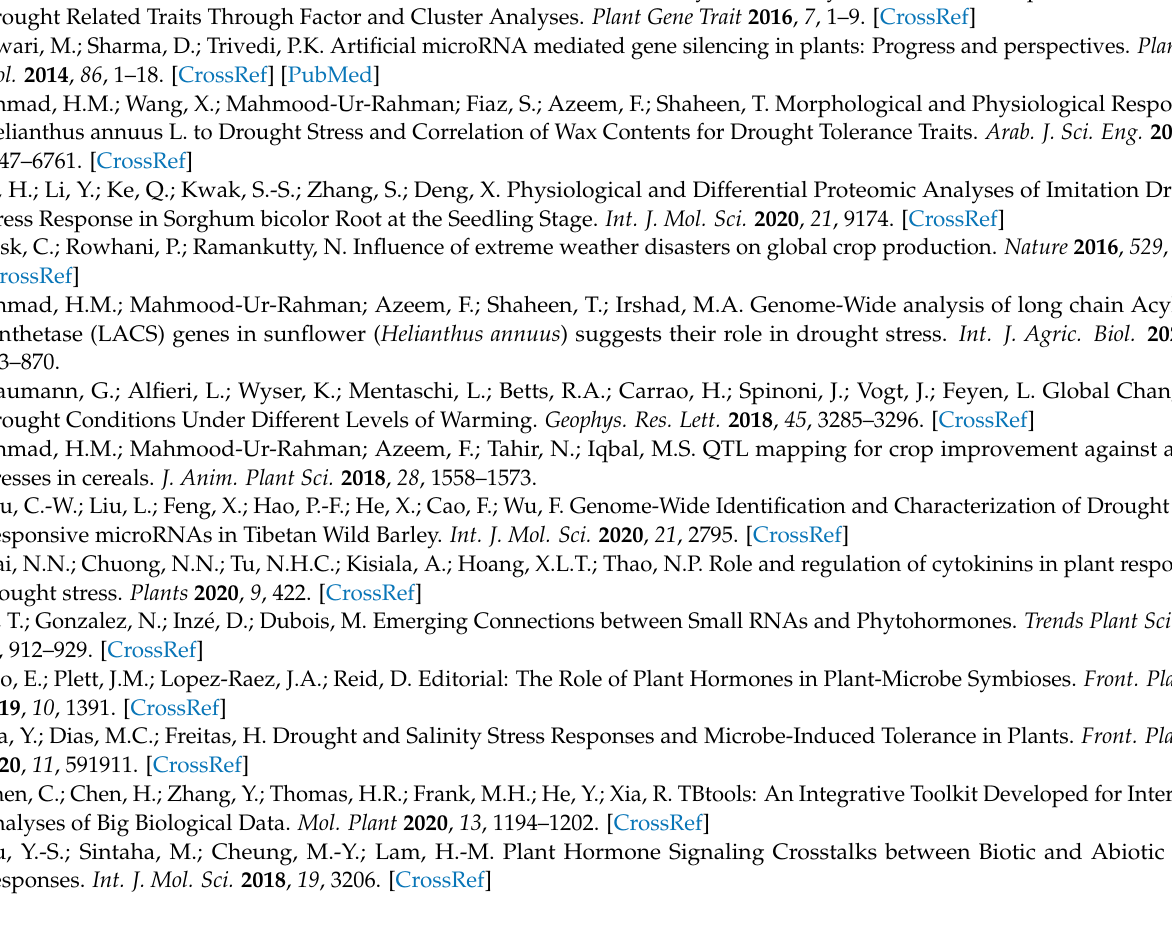
figure drawing, tables improvement, and conclusion writing. H.M.A. and M.-U.-R. prepared